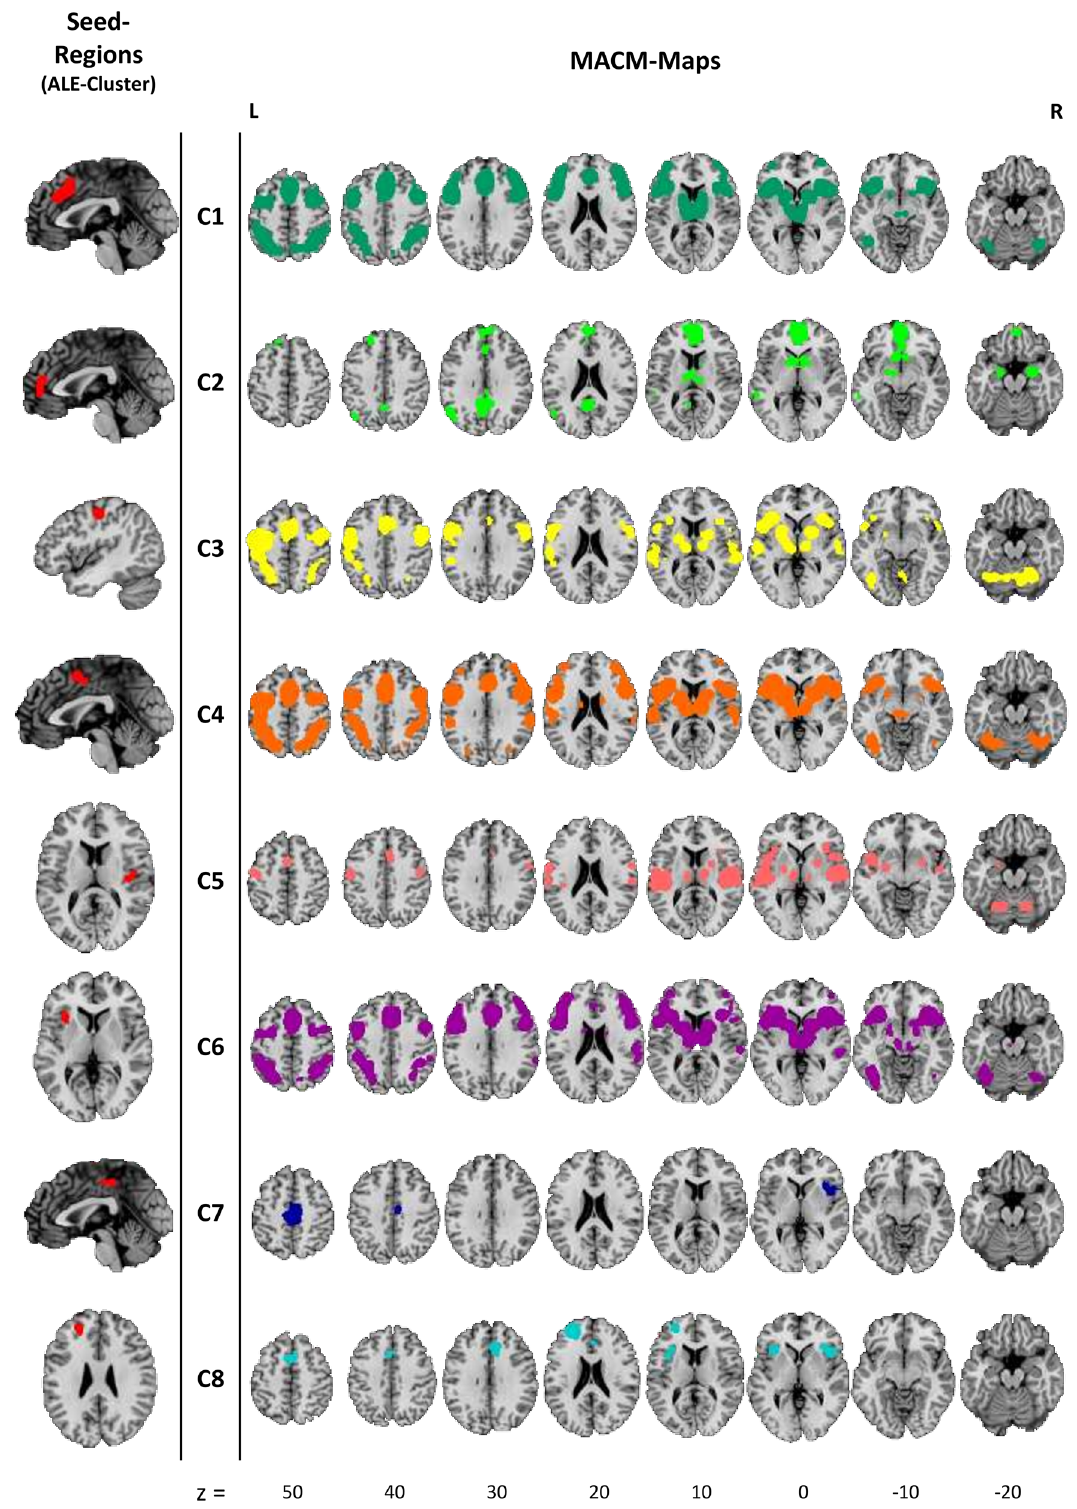
Figure 6. Results from the meta-analytic connectivity modelling (MACM). Left: Seed regions (ALE cluster), right: MACM-maps. All clusters were significant at a cluster-forming threshold of p < 0.001 and FWE cluster level corrected at p < 0.05. Z values indicate axial slice position in Talairach space. This image was created with Mango v4.1. (http://ric.uthsc sa.edu/mango